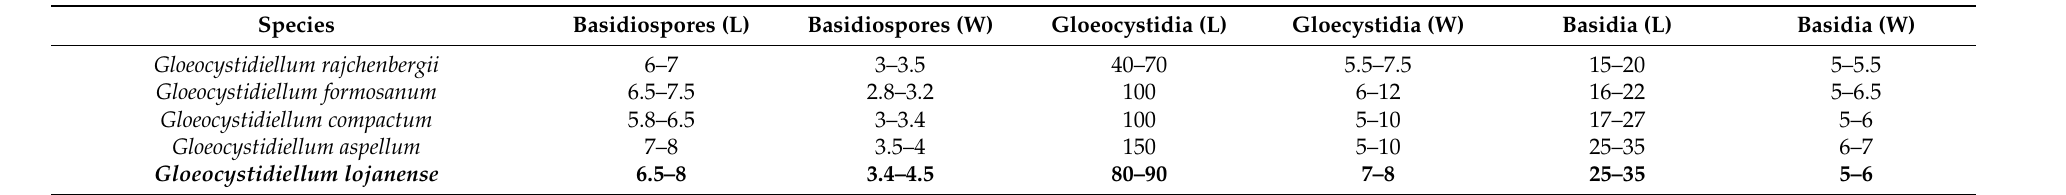
Table 3. Comparison of size measurements between representative structures of Gloeocystidiellum lojanense versus the most morphologically related species into the genus Gloeocystidiellum , according the data from Donk [50].